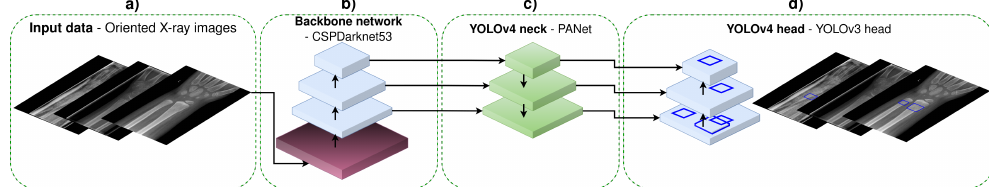
Figure 2. YOLOv4 main parts. ( a ) Preprocessed and augumented input data. ( b ) Backbone network—CSPDarknet53 for feature extraction. ( c ) YOLOv4 neck—PANet for feature